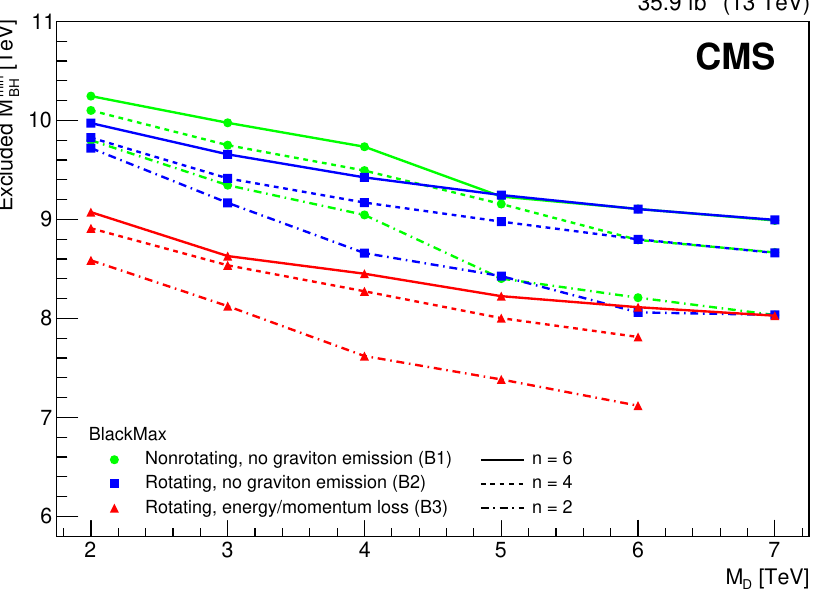
Figure 9 . The observed 95% CL lower limits on M min models B1{B3 generated with BlackMax